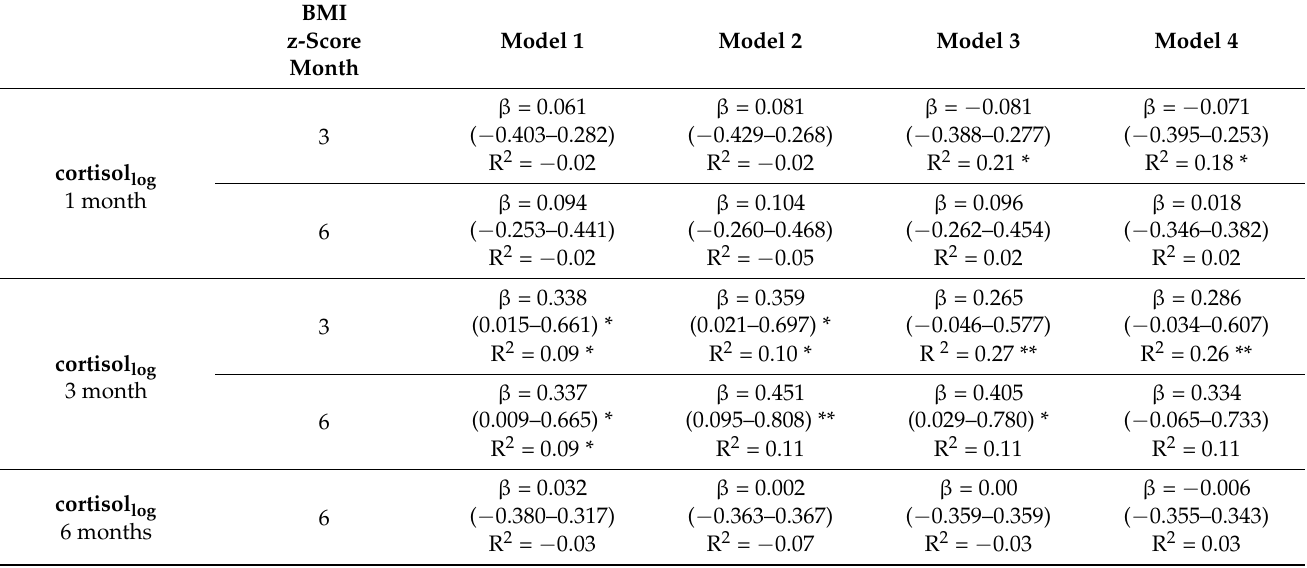
Table 6. Linear regression models between breastmilk cortisol(log) and infant anthropometric